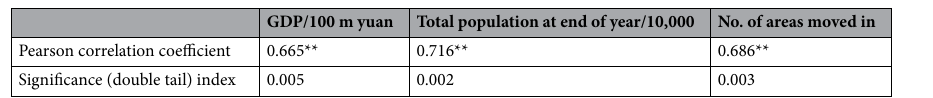
Table 2. Correlation index statistics of the number of confirmed COVID-19 patients at city-level. ** P < 0.01.